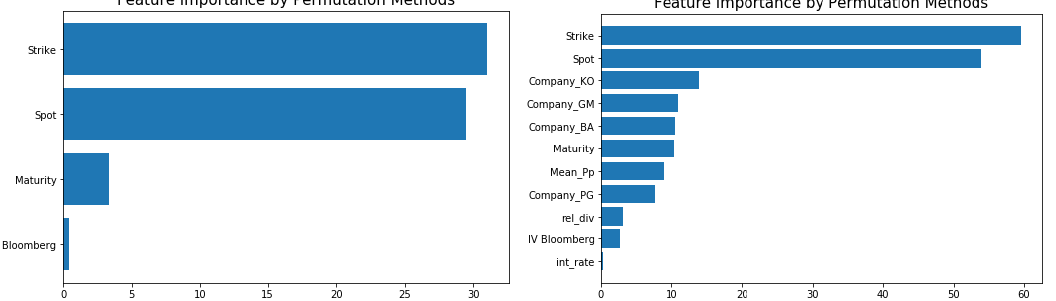
Figure 12. Inputs’ permutation results. NN Model 1 (on the left) and NN Model 2 (on the right). The x-axis shows the increase, in percentage, of RMSE that results from considering one of the inputs randomized instead of the calibrated